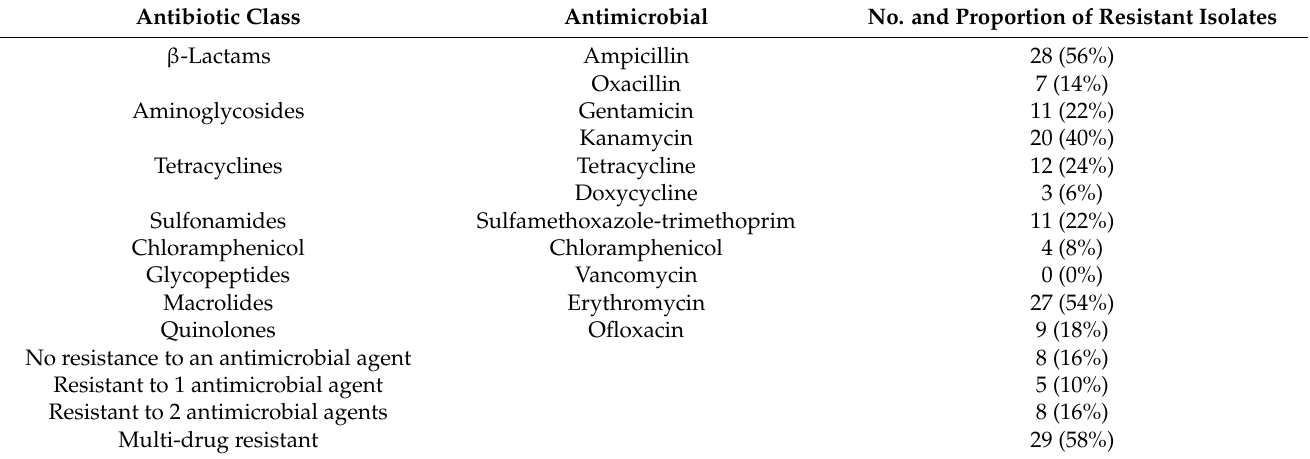
Table 5. Antimicrobial susceptibility of the study isolates to the 11 antimicrobial